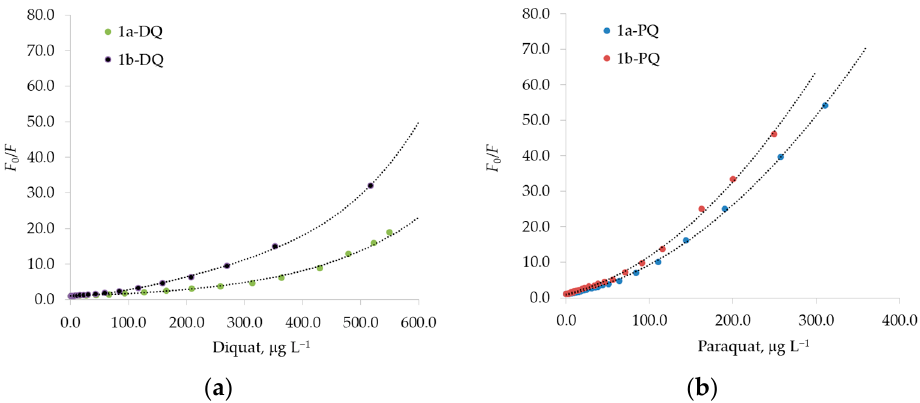
Figure 8. A modified Stern–Volmer plot of F 0 / F against increasing concentration of quencher guests. ( a ) The experimental behavior for the diquat, DQ, as quencher of 1a and 1b fluorophores. ( b ) The experimental behavior for the paraquat, PQ, as quencher of 1a and 1b fluorophores. The dashed lines represent the curvature provided by Equation (4). The excitation wavelength was set to 285 nm and 263 nm, and the fluorescence value F was measured at 336 nm and 416 nm for the fluorophores 1a and 1b, respectively. F 0 is the fluorescence intensity in the absence of quencher PQ or DQ.